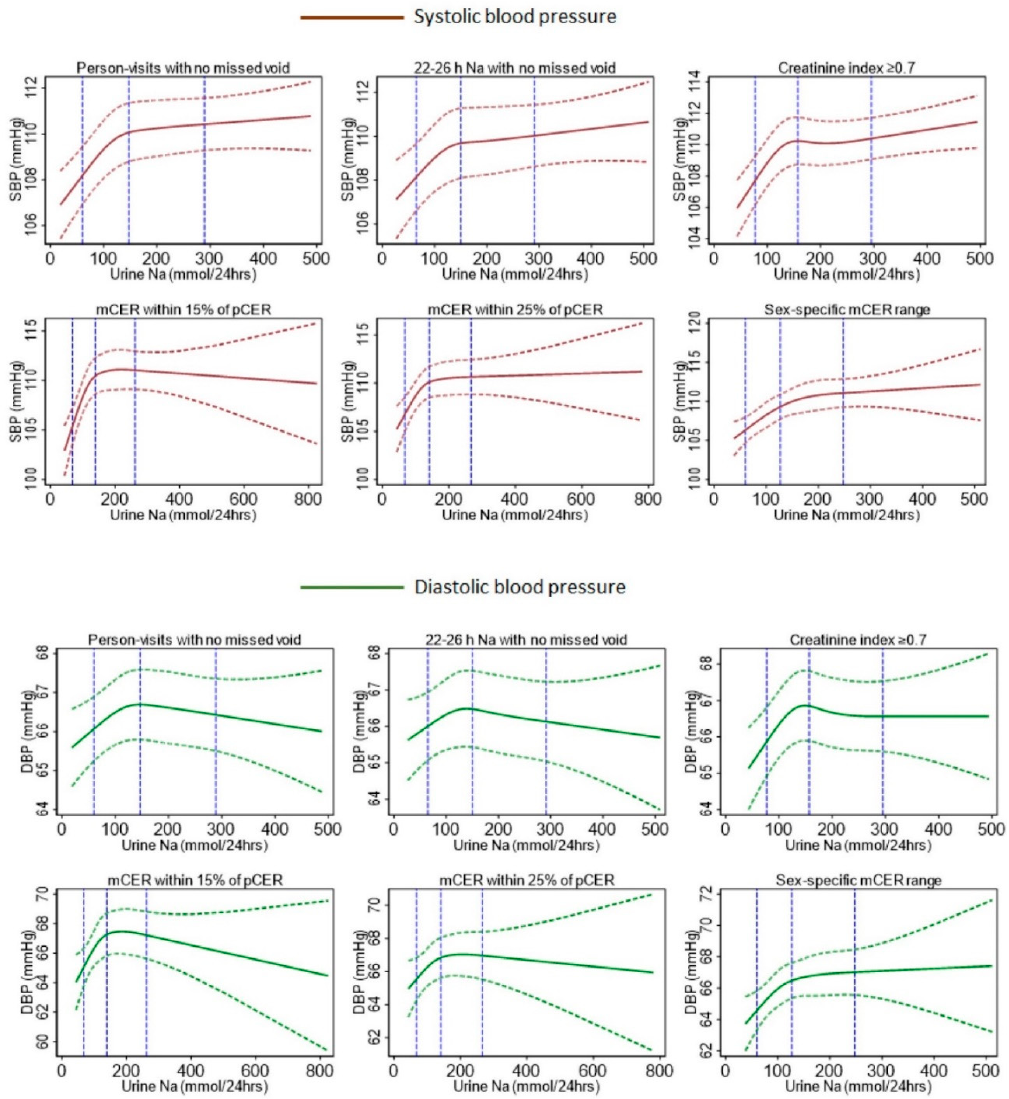
Figure 2. Restricted cubic spline pots of urinary sodium and blood pressure relationship from different method of evaluating the completeness of 24-h urine collection. Models were adjusted for age, sex, BMI, smoking status, physical activity, sleep, alcohol consumption, religion, and household wealth. Vertical dotted blue dotted lines indicate the 5th, 50th, and 95th percentile distribution of urine sodium excretion. mCER: measured 24-h urine creatinine excretion; pCER: predicted 24-h urine creatinine excretion.